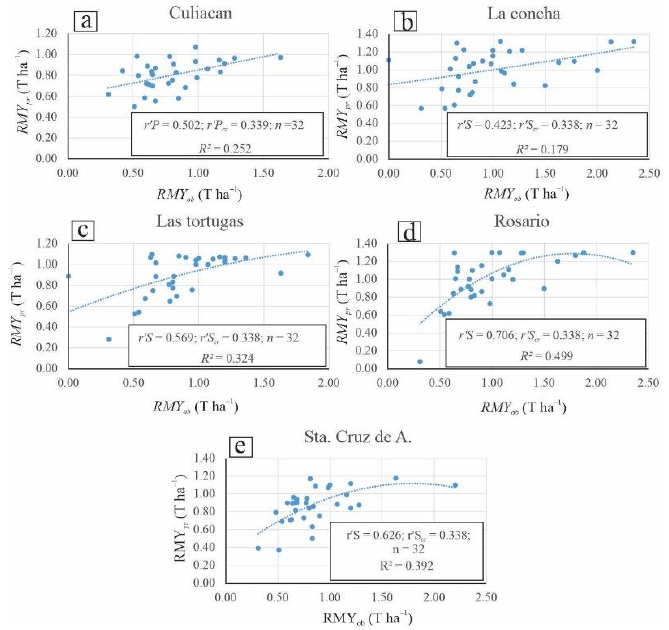
Figure 4. Validation of the models for RMY pr (T ha –1 ). ( a ) shows the single model with MLR and ( b – e ) show the four models with MNR.